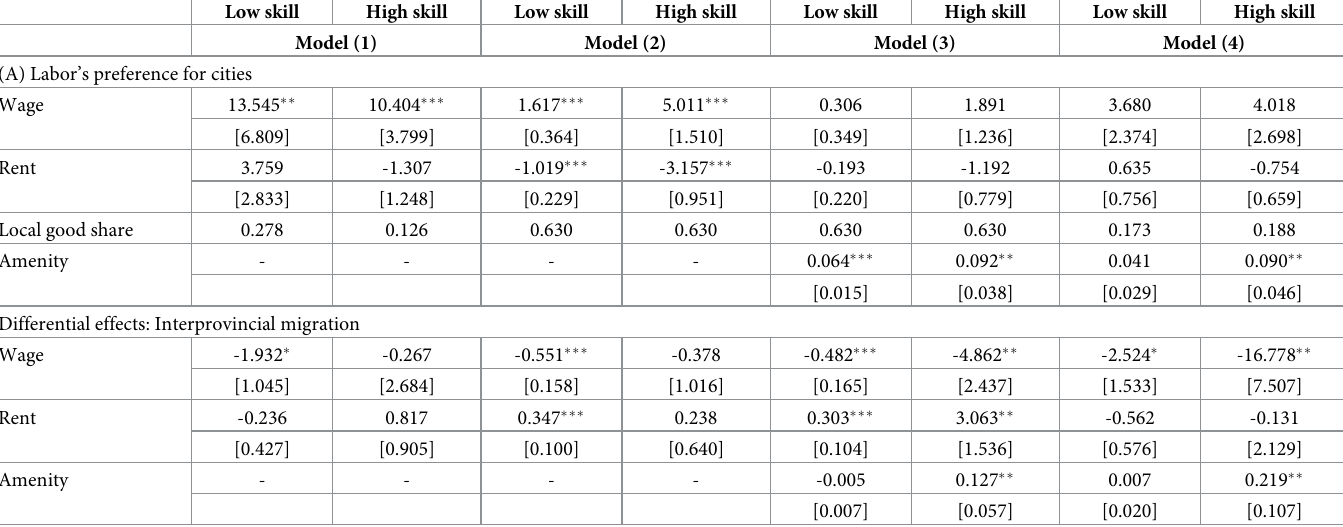
Table 5. GMM estimates of model